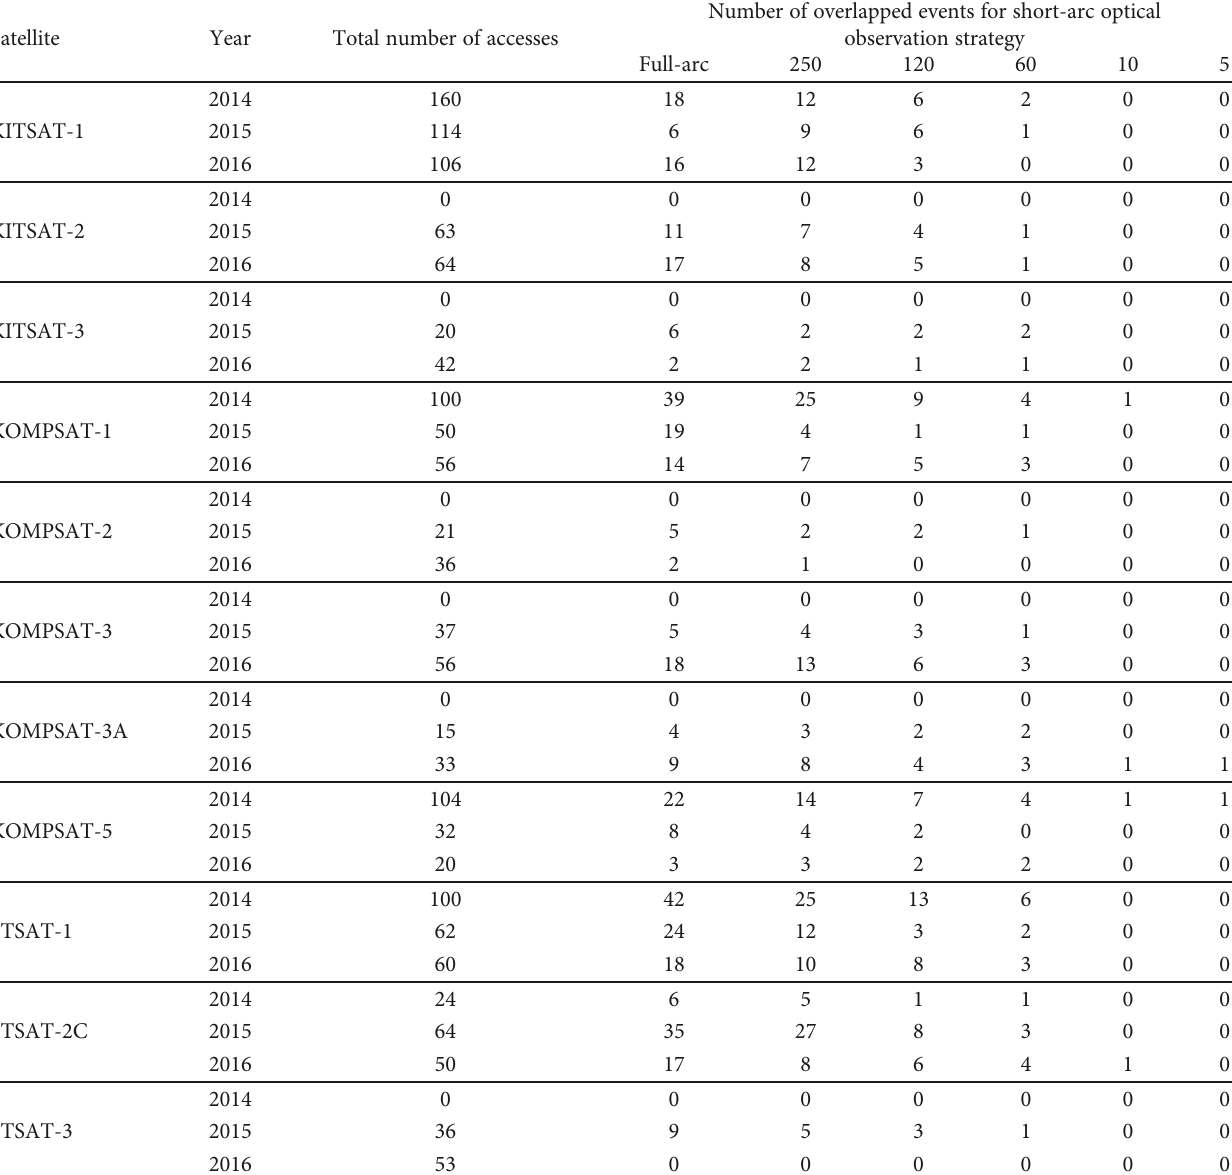
Table 2: Number of overlapped events for 11 domestic LEO satellites at the fi ve OWL-Net stations during the selected week for orbit determination test by the number of weekly optical observation overlapped events (2014: 4th week; 2015: 34th week; and 2016: 18th week).